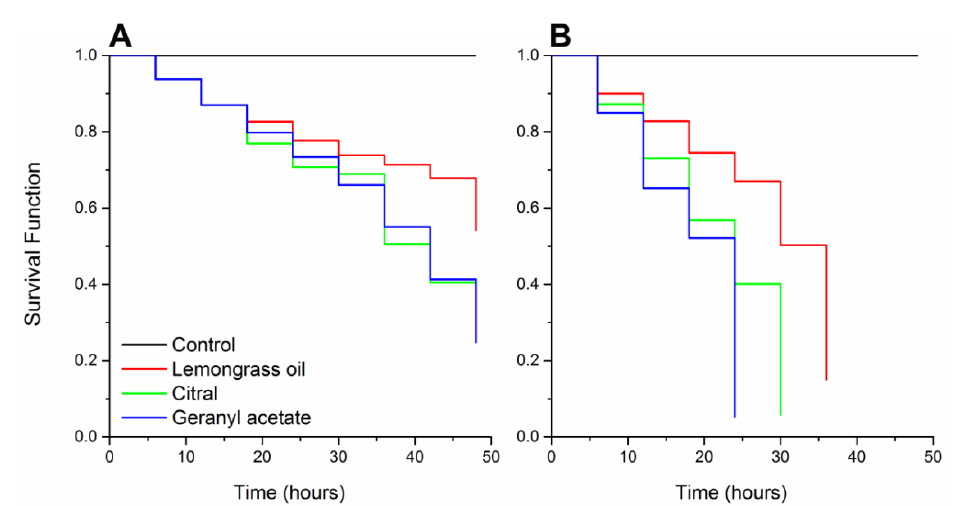
Figure 3. Survival curves of Sitophilus granarius adults exposed to lemongrass essential oil and its components, subjected to survival analyses using the Kaplan–Meier estimators’ log-rank test. Lethal dose ( A ) LD 50 ( χ 2 = 39.88; p < 0.001) and ( B ) LD 90 ( χ 2 = 105.9; p < 0.001).